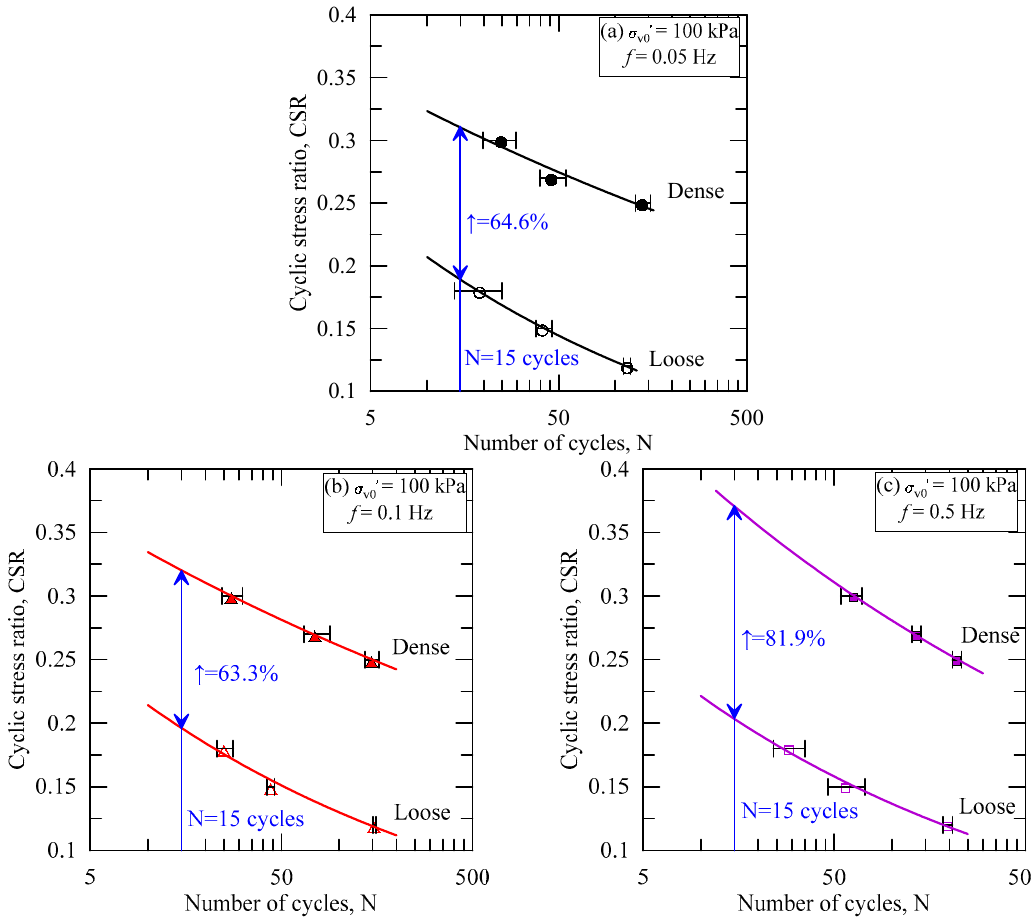
Figure 6. Comparison of cyclic resistance curves ( a ) f = 0.05 Hz, ( b ) f = 0.1 Hz and ( c ) f = 0.5 Hz at different density states for σ v0 ′ = 100 kPa.